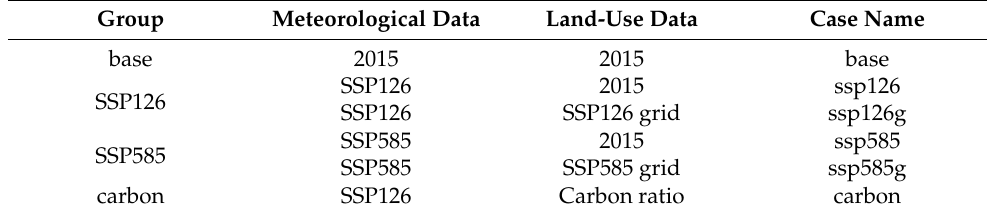
Table 2. Simulation cases in this